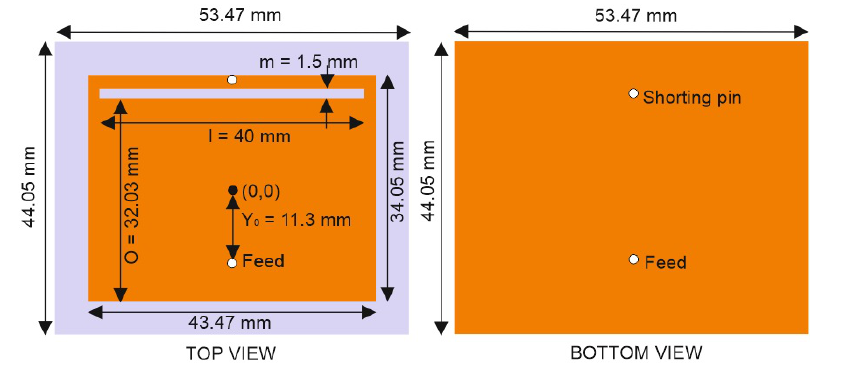
Figure 2. Configuration of the proposed